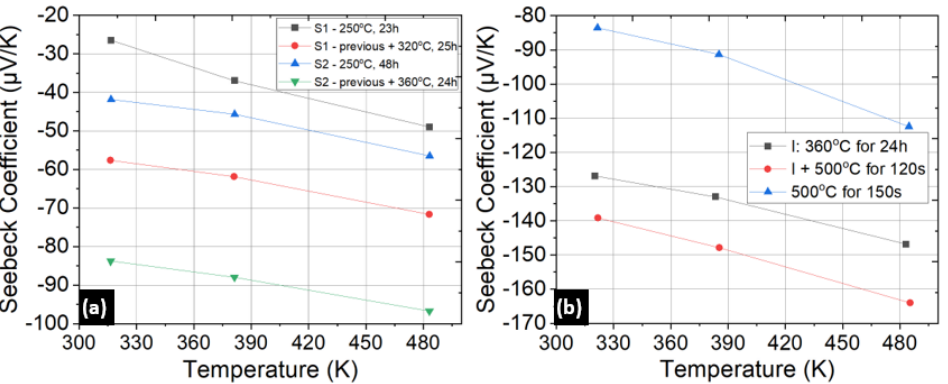
8 of 20 Figure 6. ( a ) Power factor of p-type thin films showing the correlation between the Te composition in the pellets and the thermoelectric performance. All samples were baked for 24 h at 250 °C before measurement. ( b ) Seebeck coefficient measured for n-type thin films prepared with the pellet com- positions stated in the legend. Poor quality n-type thin films with Seebeck coefficients below − 80 µV/K were observed, and a mildly positive S was seen for the Se6xTe2x case.